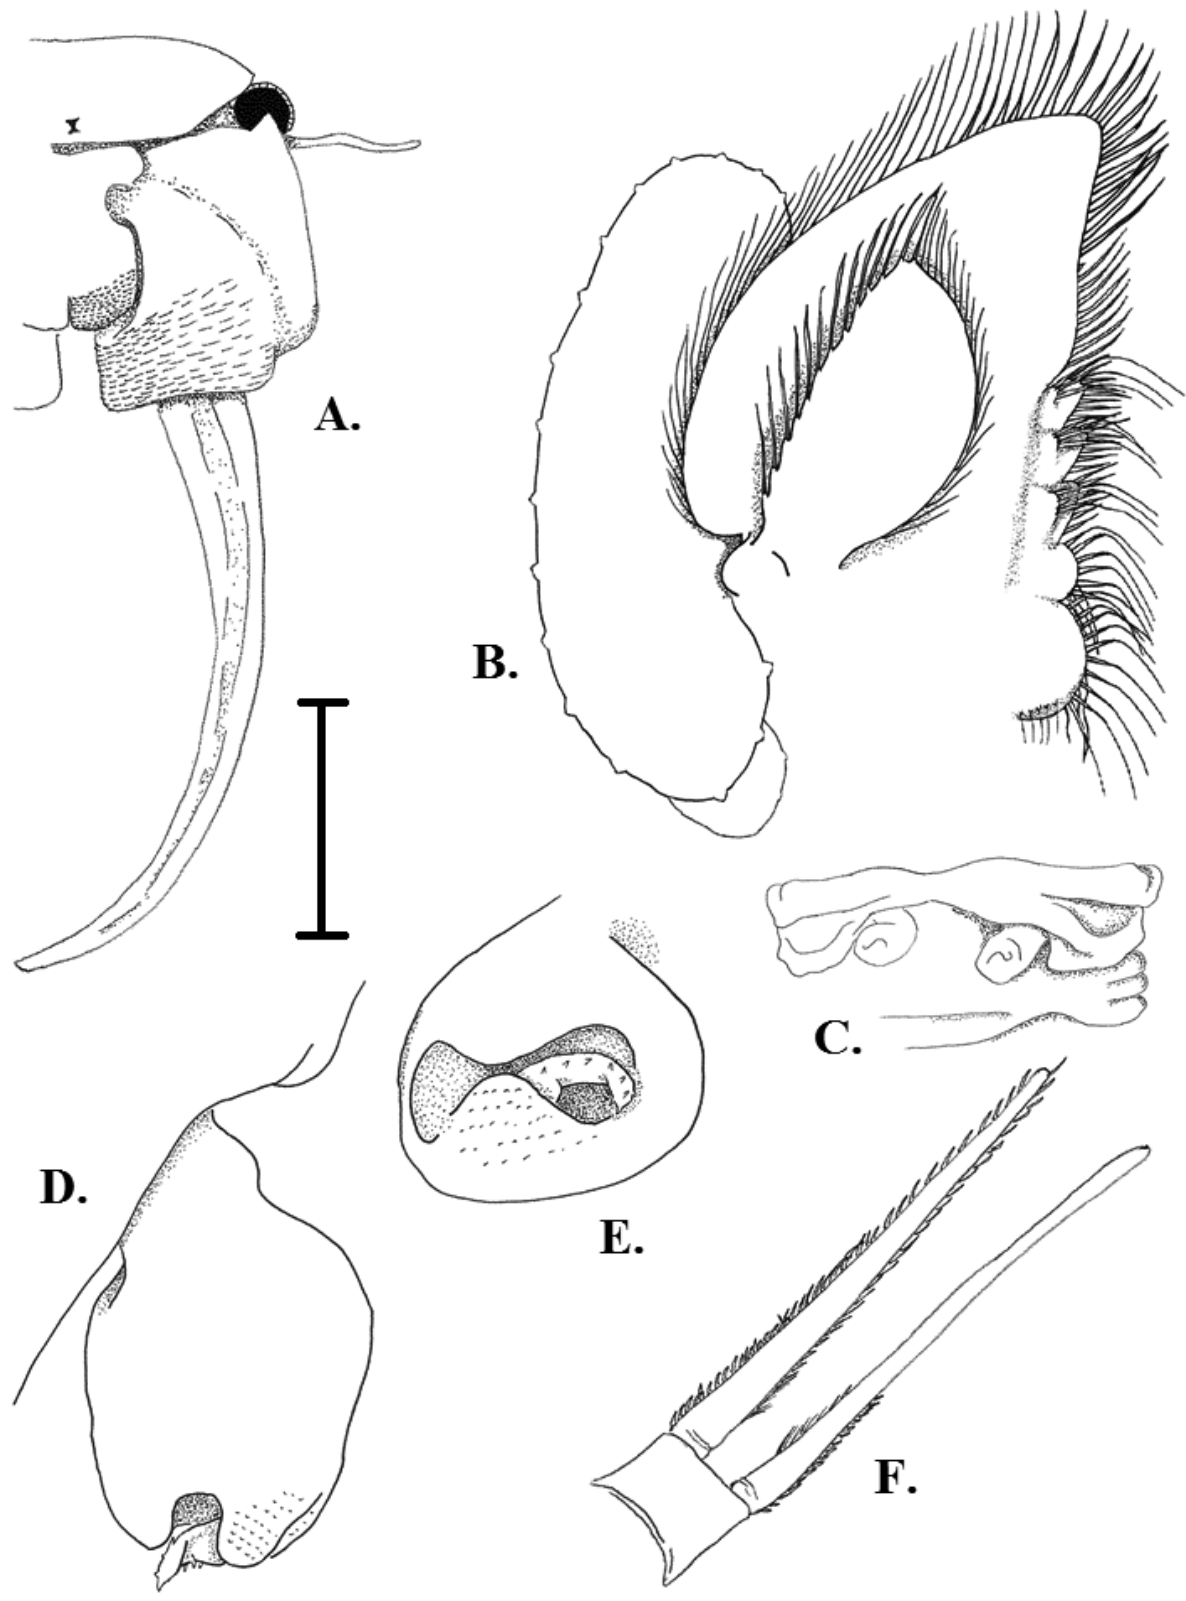
Figure 1. Aeginecta longicauda n. gen., n. sp. holotype, male: A) Left side of head anterior view. B) Right thoracopod V, anterior view. C) Genital segment, ventral view. D) Left gonopod, left lateral view. E) Left gonopod, distal view. F) Telson and cercopods, ventral view. Scale bar: A & C) = 2mm; B) = 1.5mm; D & E) = 300 μm; F) =